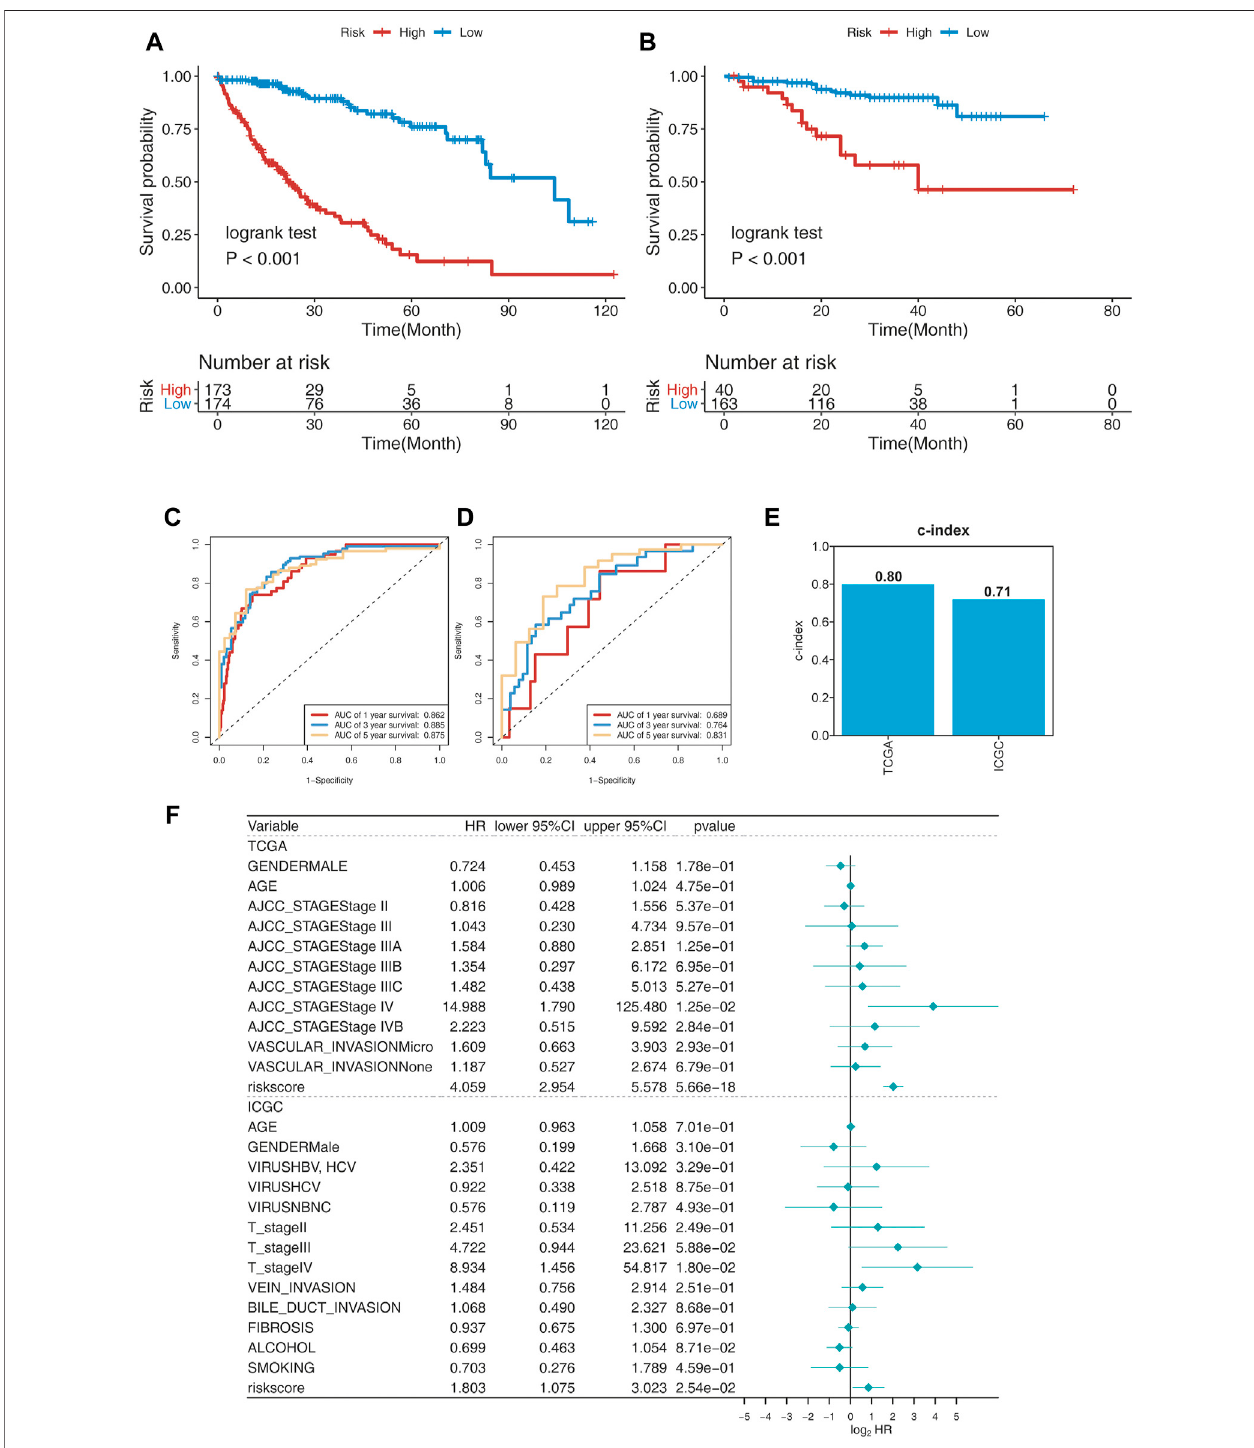
FIGURE 3 | Evaluating the prognosis-predicting ef fi cacy of this 25-gene signature. (A,B) Kaplan – Meier plot of TCGA (A) and ICGC (B) cohorts. (C,D) tROC curve of the 25-gene signature in TCGA (C) and ICGC (D) cohorts. (E) C-index of the 25-gene signature was 0.8 in the TCGA cohort and 0.71 in the ICGC cohort. (F) Multivariate Cox regression analysis of clinical parameters and risk scores for OS.